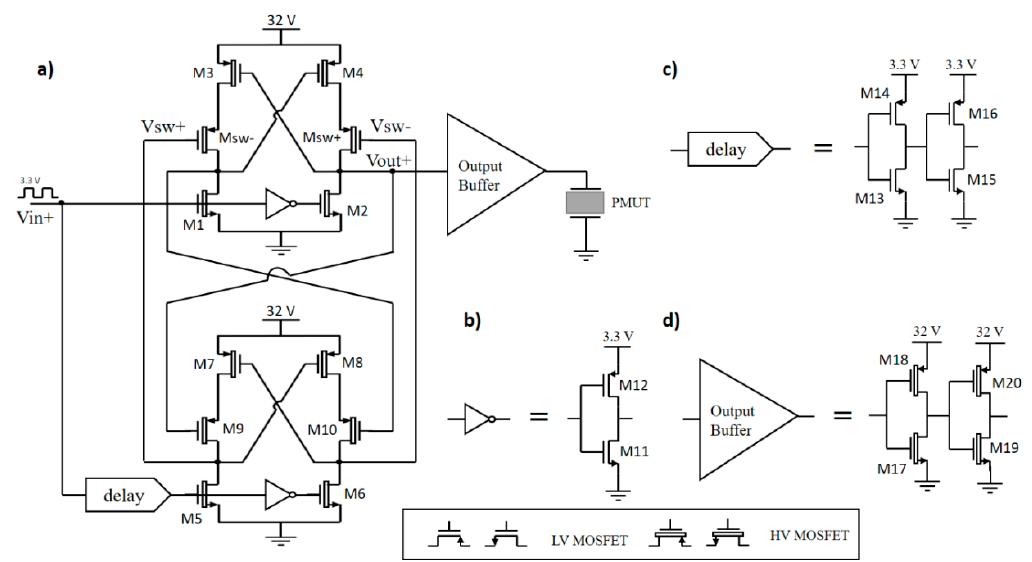
Figure 2. Schematic of the high-voltage transmitter. ( a ) Complete architecture to excite the piezoelectric micromachined ultrasonic transducer (PMUT). ( b ) An inverter circuit. ( c ) Cascaded inverter used as a delay element and ( d ) an output buffer using an inverter string to drive large capacitive loads.